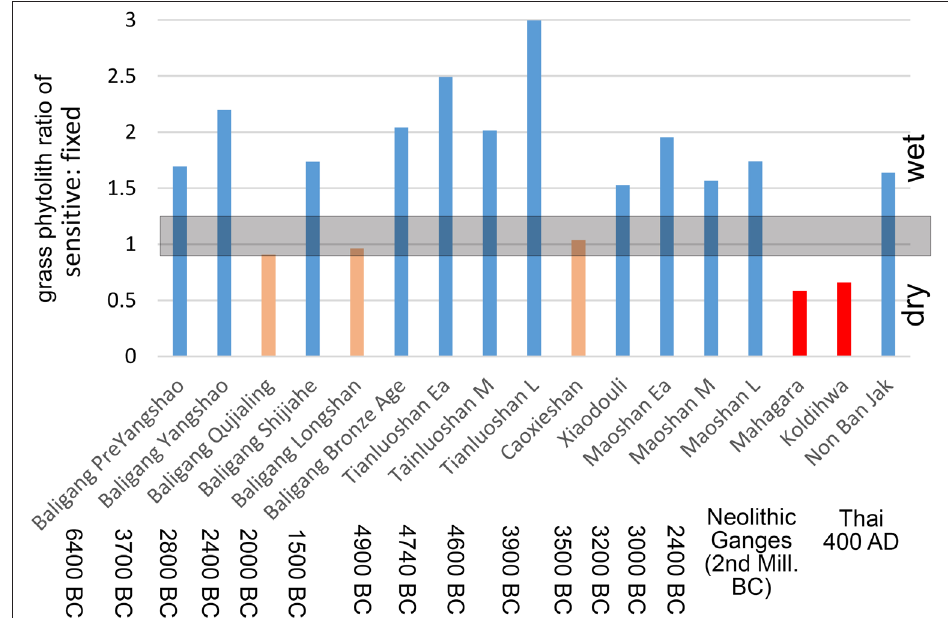
Figure 5: The sensitive: fixed grass phytolith ratio for various sites and phases (averaged across multiple samples), indicating in blue those that are inferred to represent wet field ecology, in red those that are dry field ecology and those in orange that are somewhat dry or intermediate. Phytolith analyses by ARW. Based on 138 samples and at least 300 single cells counted per sample (Chart prepared by